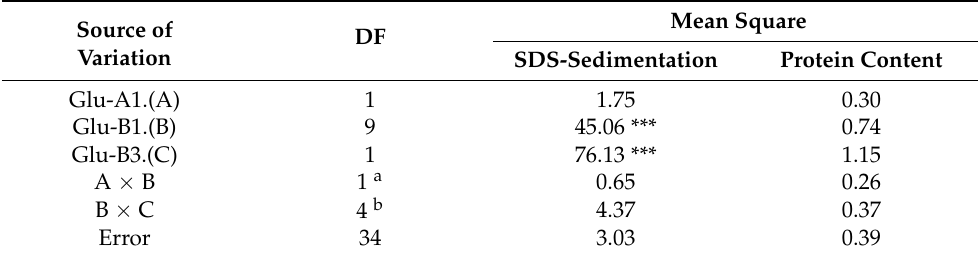
Table 3. Analysis of variance (ANOVA) for the protein content and SDS volumes with main effects of HMWGS and LMWGS loci and their two-way interactions. Source of DF Variation